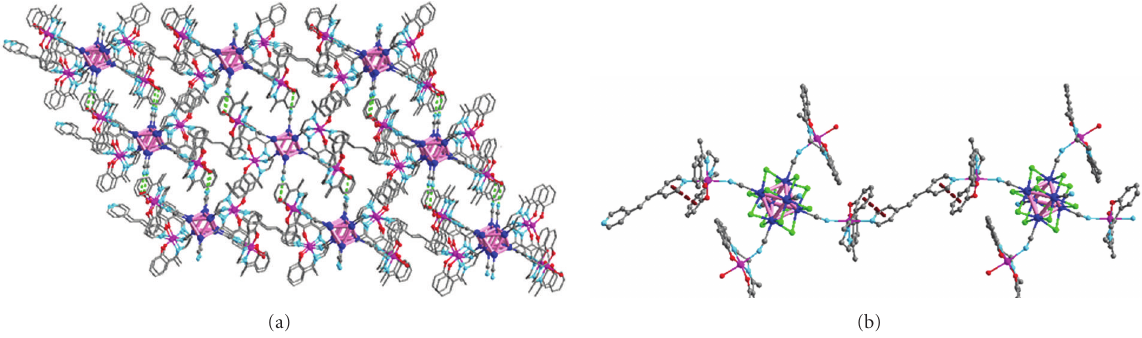
Figure 2: The structure of 2 . (a) The packing diagram viewed along the a direction. Cl atoms and free solvent molecules are omitted for clarity. Hydrogen bond is represented as a dotted green line. (b) The 1D neutral chain, π - π interaction is represented as a dotted red line.